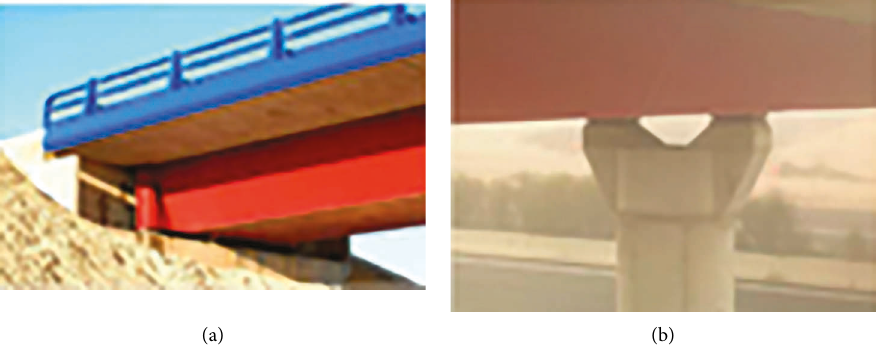
Figure 3: Details of the construction: the abutment (a) and the pier (b) of the Magaz